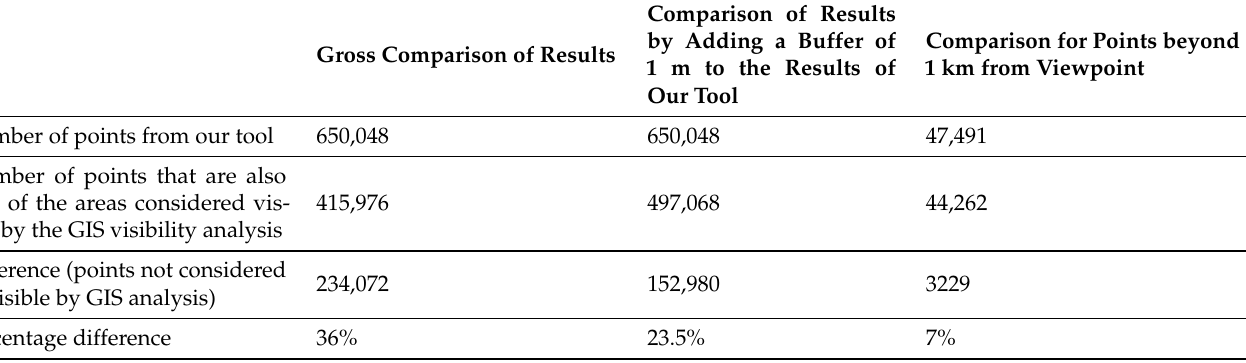
Table 2. Difference between the results of a raster visibility analysis and those from our tool for the viewpoint from the Basilica of